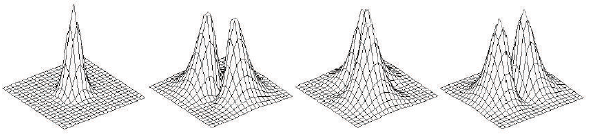
Figure 2: The four smoothing filters that are used for 2D CCA, one small isotropic separable filter and three anisotropic nonseparable filters. For visualization purposes, these filters are interpolated to a subpixel grid.